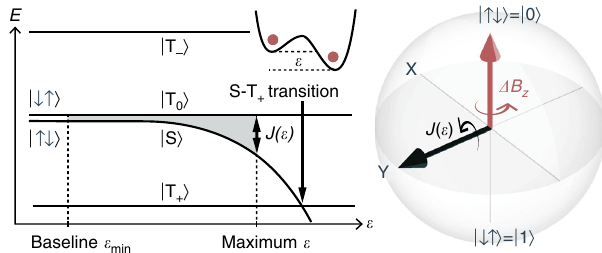
Fig. 1 S − T 0 qubit energy diagram and Bloch sphere. The eigenenergies change as a function of detuning ϵ , which is used to control the exchange coupling J ( ϵ ). The ϵ pulses presented in this work start and fi nish at a baseline ϵ min with low J and pulse to higher values for short periods. The maximum amplitude is constrained to below the S − T + anticrossing at large ϵ . We choose the convention that J ( ϵ ) points along the y -axis of the Bloch sphere. For low ϵ amplitudes, the qubit rotates about Δ B z , the z -axis of the Bloch sphere. Large amplitude ϵ pulses rotate the qubit about the y -axis and thus enable arbitrary single-qubit